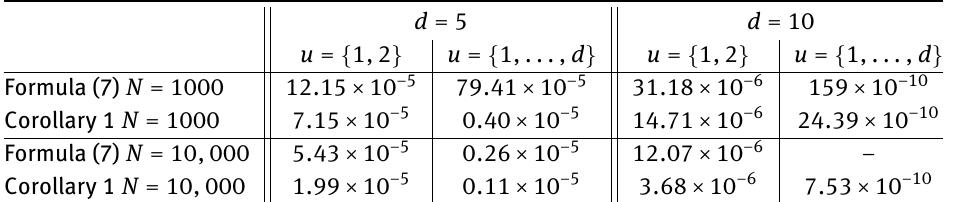
Table 2: AME for the estimation of Υ 2 u when ψ ( x ) = max( x ) . Missing value – refers to exceeding the time limit. d = 5 d = 10 u = { 1, 2